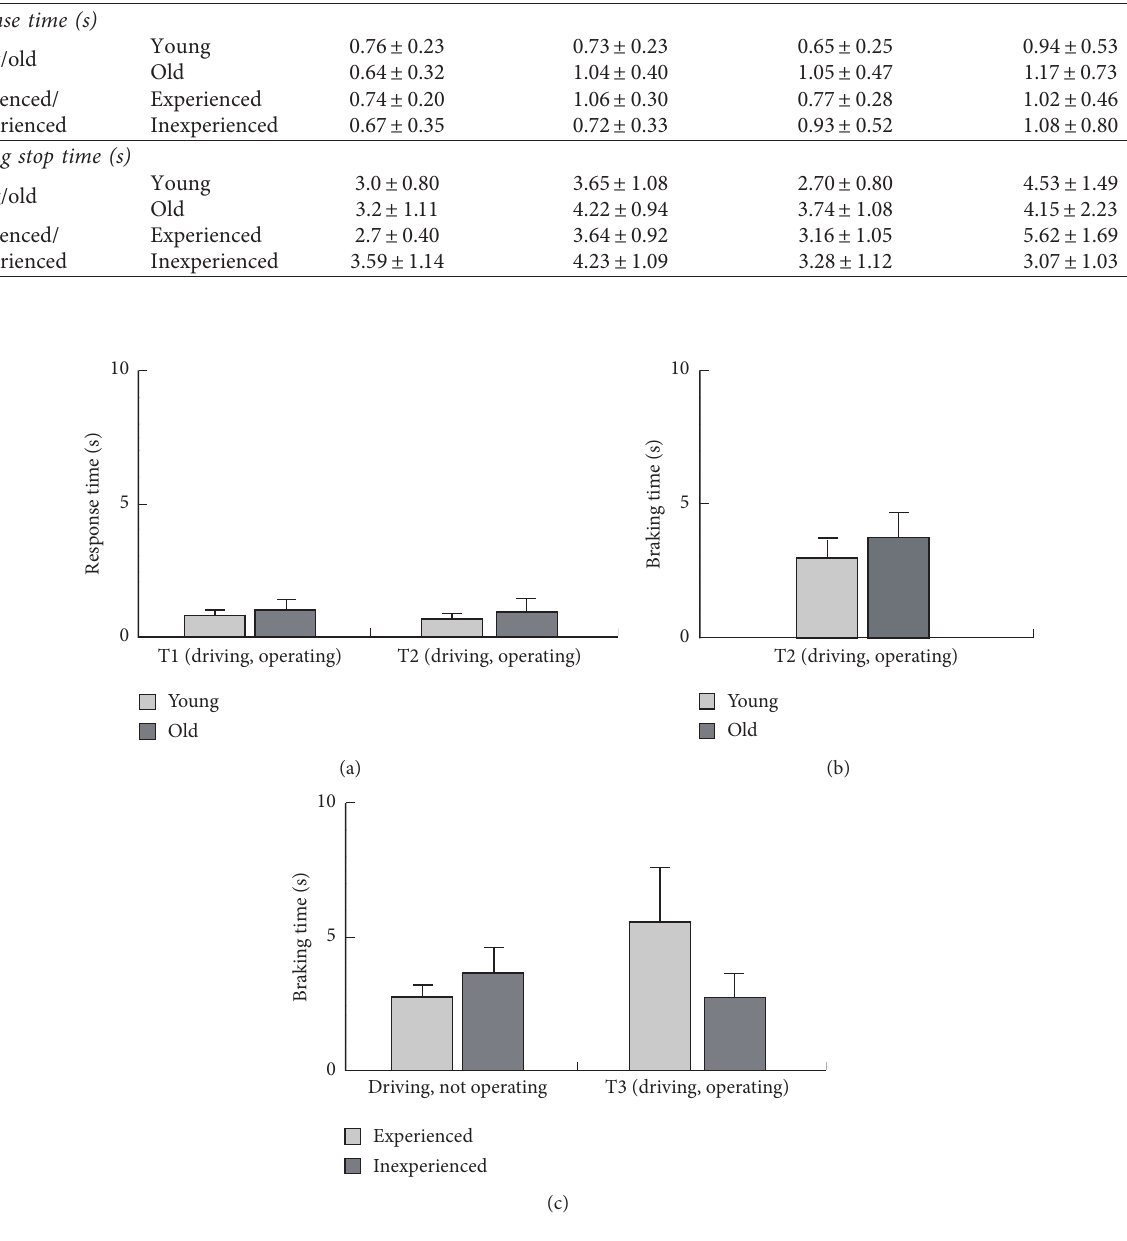
Table 7: Descriptive statistics of mean and standard deviation of response time and braking stop time among different age and experience. Group